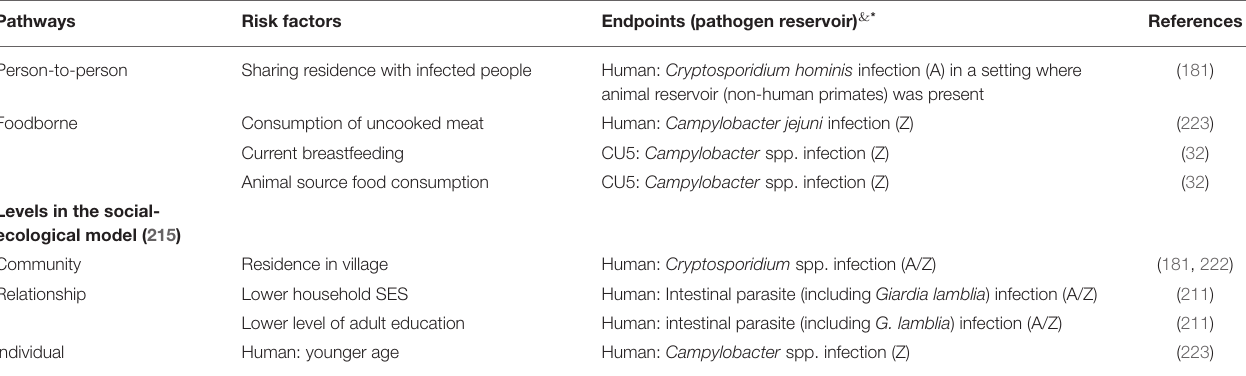
TABLE 5 | Risk factors associated with the presences of zoonotic enteric pathogens in different endpoints (human at all age range, and children under-five) fallen under the social-demographic category or through the foodborne and person-to-person pathways in smallholders in LMIC.